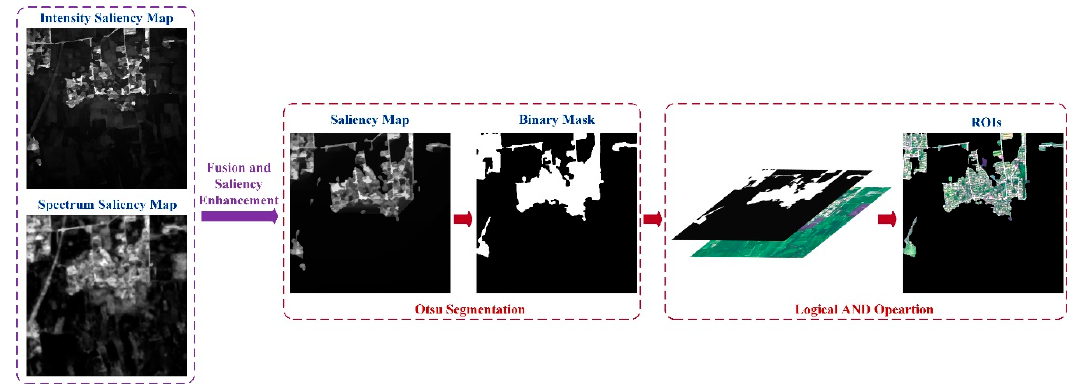
Figure 6. Saliency enhancement and ROI extraction.